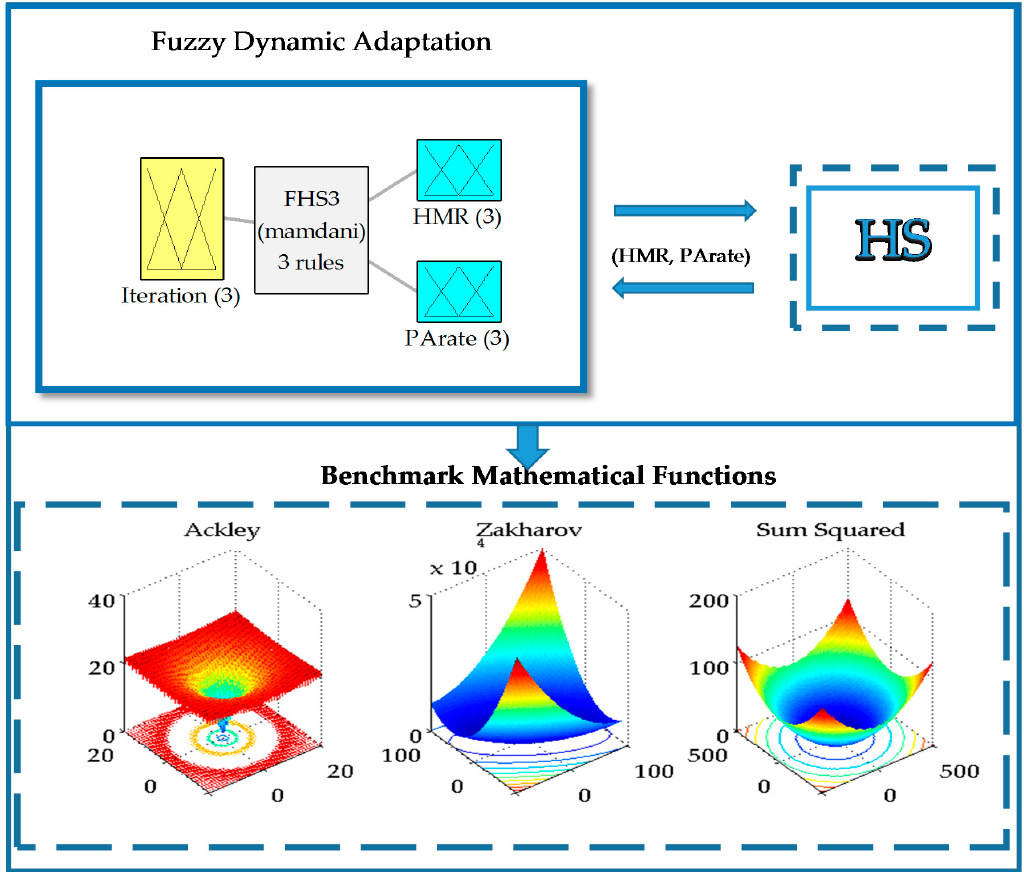
Figure 1. Proposal for fuzzy dynamic adaptation of HS.